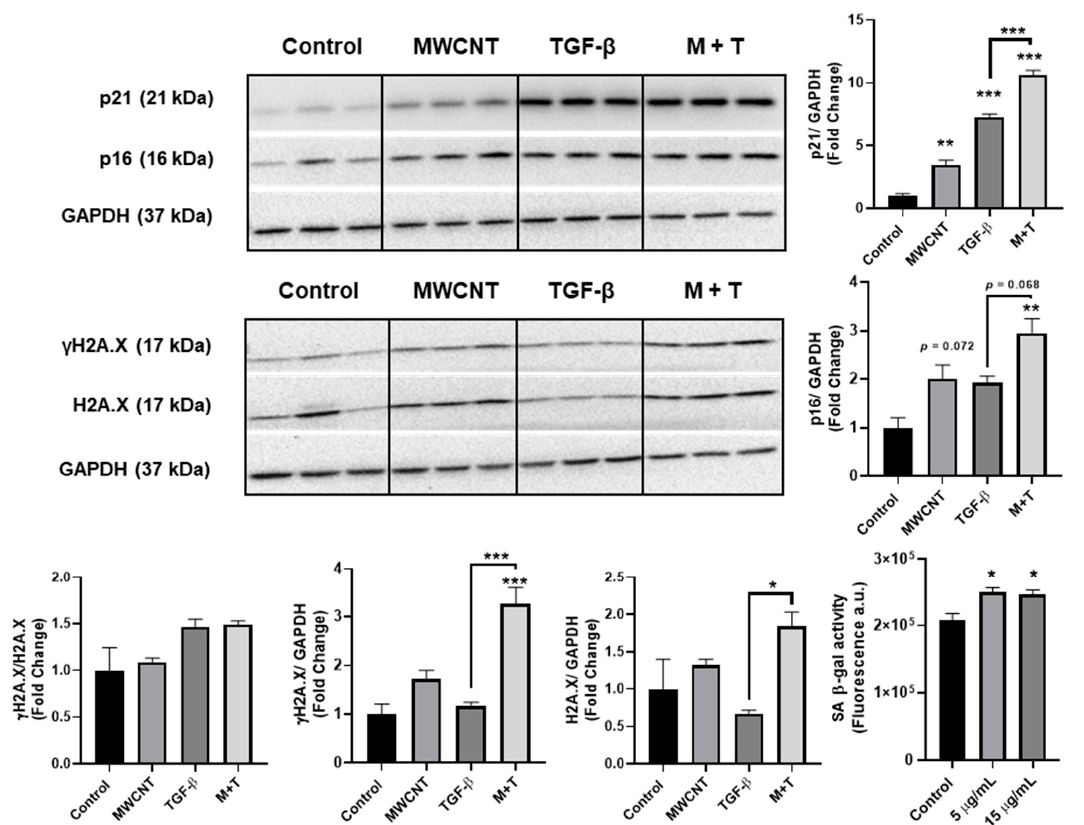
Figure 2. MWCNT and TGF- β exposure propagate cellular senescence. BEAS-2B were exposed to MWCNT (5 µ g/mL) and/or TGF- β (5 ng/mL) for 72 h. The activity of SA β -gal and the protein abundance of senescence markers ( γ H2A.X, H2A.X, p16, and p21) are shown. Data are presented as fold change relative to control. Data are shown as mean ± SEM ( n = 3/group), * p < 0.05, ** p < 0.01 *** p < 0.01 indicates significance. M + T: Combined MWCNT and TGF- β treatment. An equal volume of DPPC was added to control.